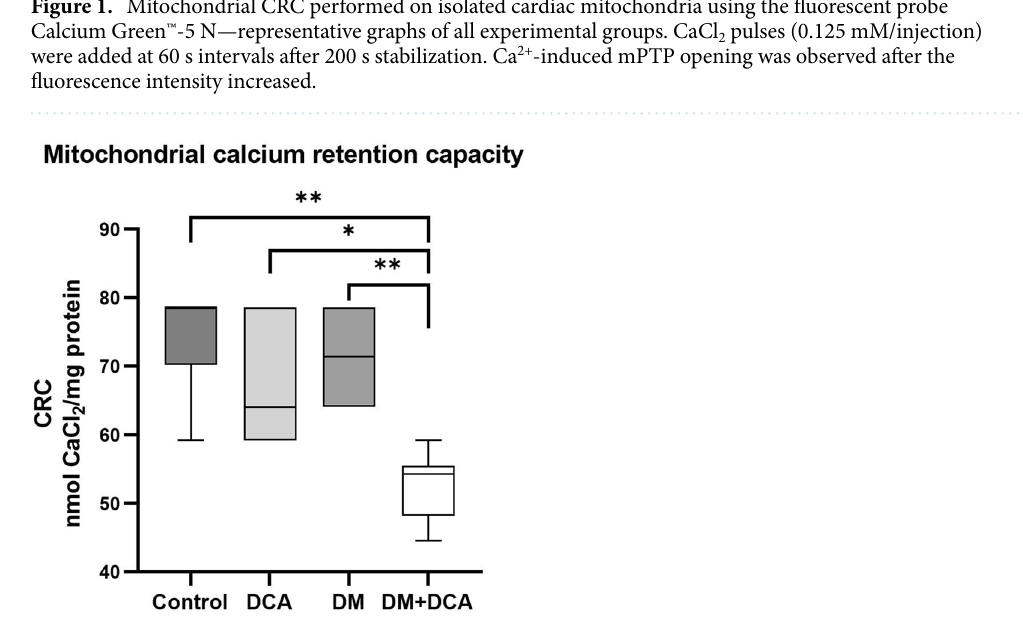
Figure 2. Changes in the CRC of isolated cardiac mitochondria induced by DCA treatment and by experimental DM conditions . CRC was maintained in the DM group versus the Control group. DCA application in the DM group significantly reduced CRC. Control—untreated control group; DCA—control group treated with dichloroacetate; DM—diabetic group; DM + DCA—diabetic group treated with dichloroacetate. Box plot graph displays minimum and maximum values and median shown by a horizontal line. n = 6 per group; *− p < 0.05; **− p < 0.01. Control versus DM + DCA ( p = 0.0012), DCA versus DM + DCA ( p = 0.0268), DM versus D + DCA ( p =